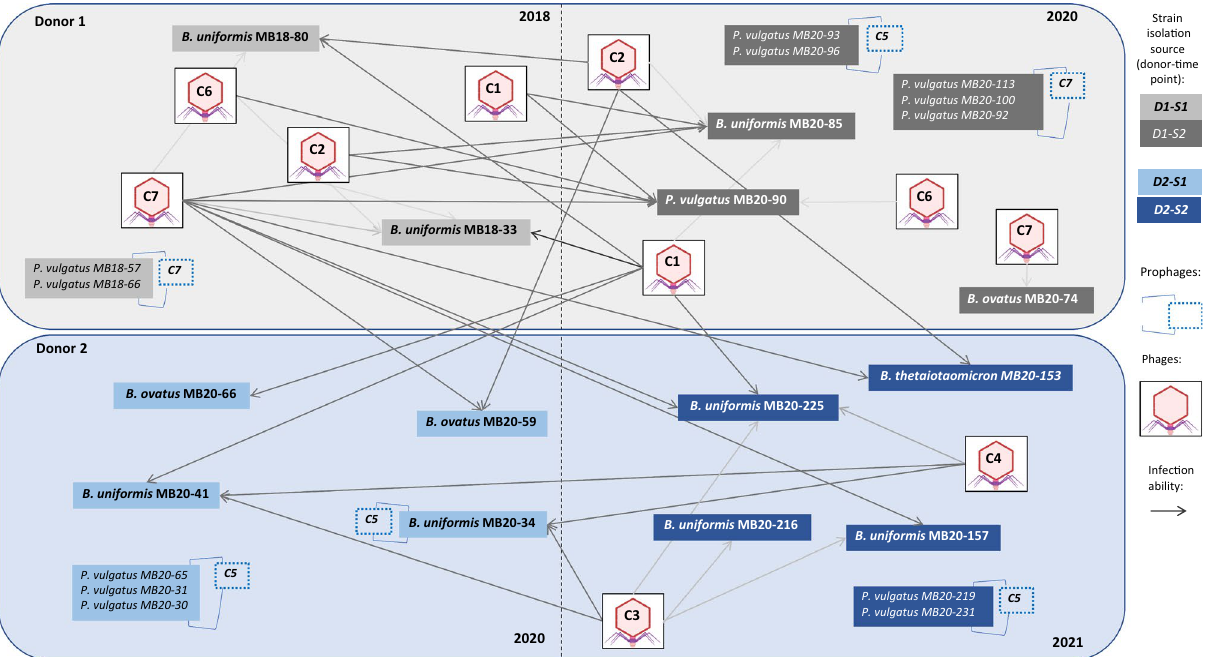
Figure 4. Network visualization of infection ability according to the strain source and time point shows that phages are not donor-specific. Each compartment represents an isolation time point per donor. Phages isolated at specific time points infect strains from temporally distant time points or even different donors. Prophages from the described phage clusters in this study are also